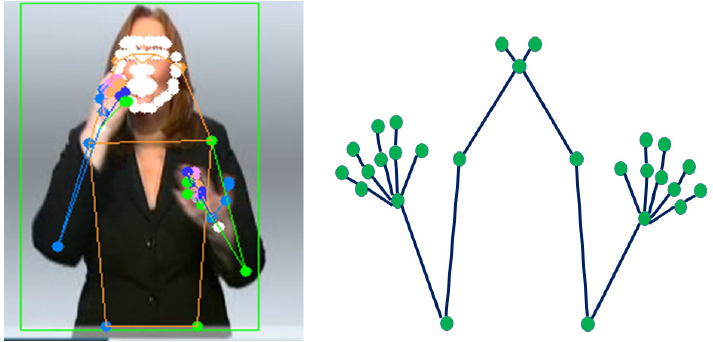
Figure 4. Keypoint features of PHOENIX-RWTH dataset [33,39], ( left image) extraction from RGB image, and the ( right image) is the selected keypoint used by the proposed model.